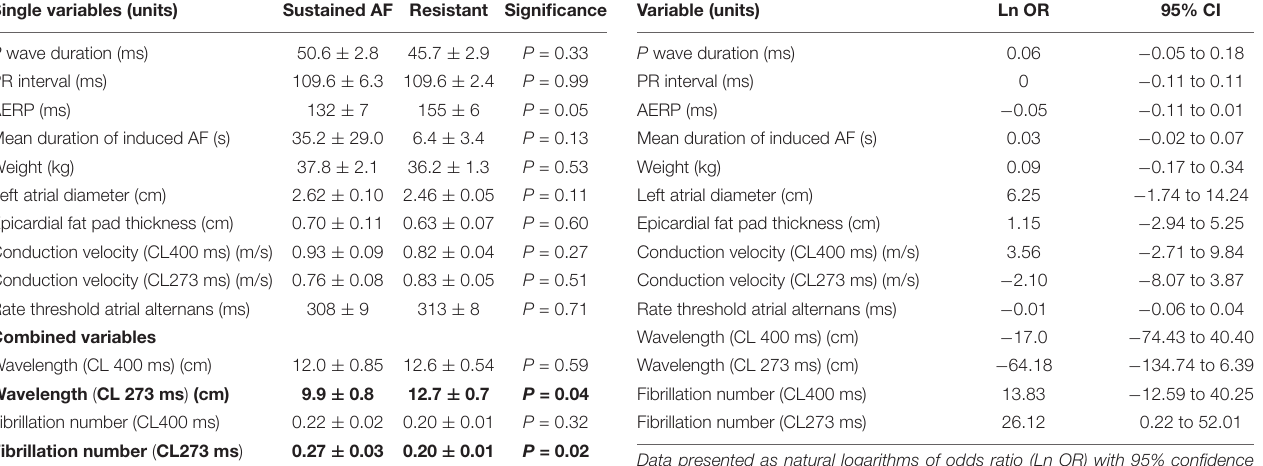
TABLE 2 | Univariate logistic regression analysis of single baseline characteristics between the sheep who develop sustained AF and those who were resistant. Variable